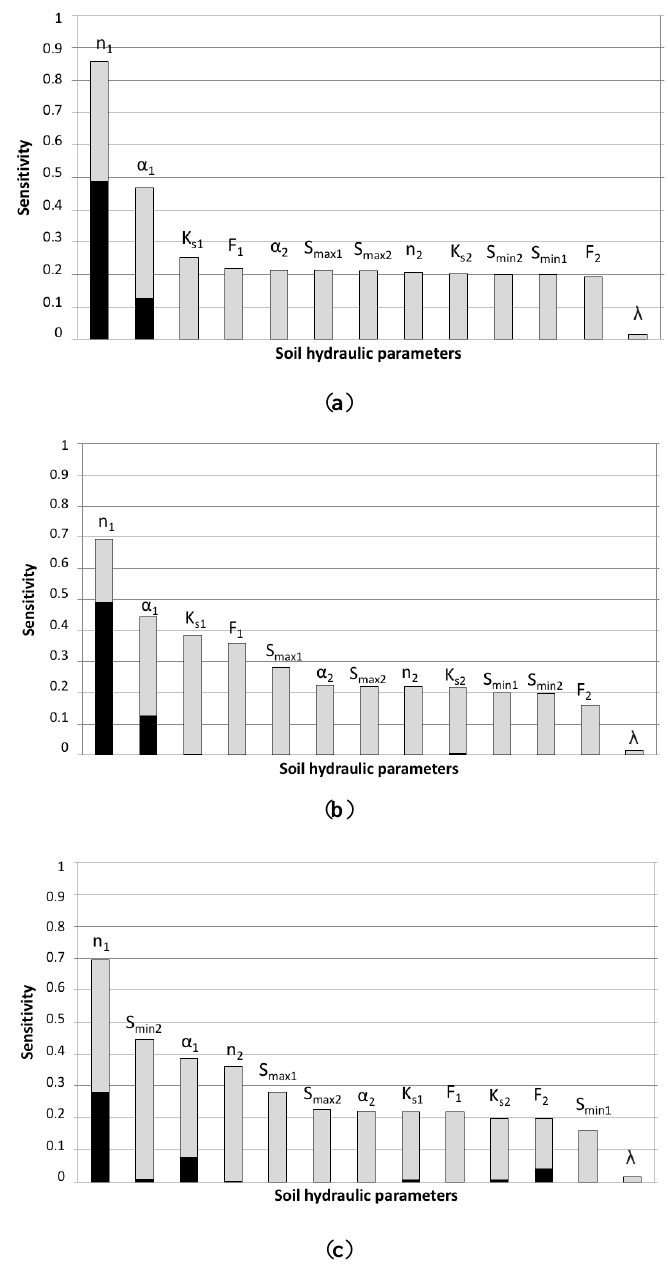
Figure 2. Results of the Sobol method sensitivity analysis for different model outputs: ( a ) groundwater recharge (1096 days of simulation); ( b ) water content profile after 1044 days of simulation*; and ( c ) pore water isotope profile after 1044 days of simulation*. S 1 is shown in black and S T is shown in gray. Soil hydraulic parameters are ranked by decreasing influence. * 1044 days of simulation correspond to 9 November 2018. Results were checked to be independent of the chosen